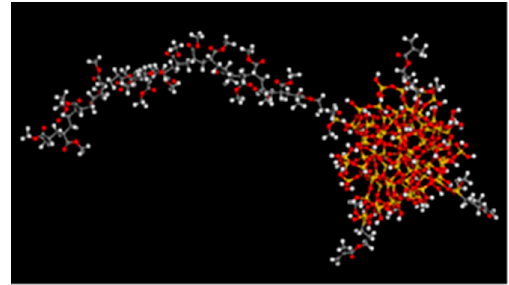
Figure 4. Model of PMA-KH570-SiO 2 .